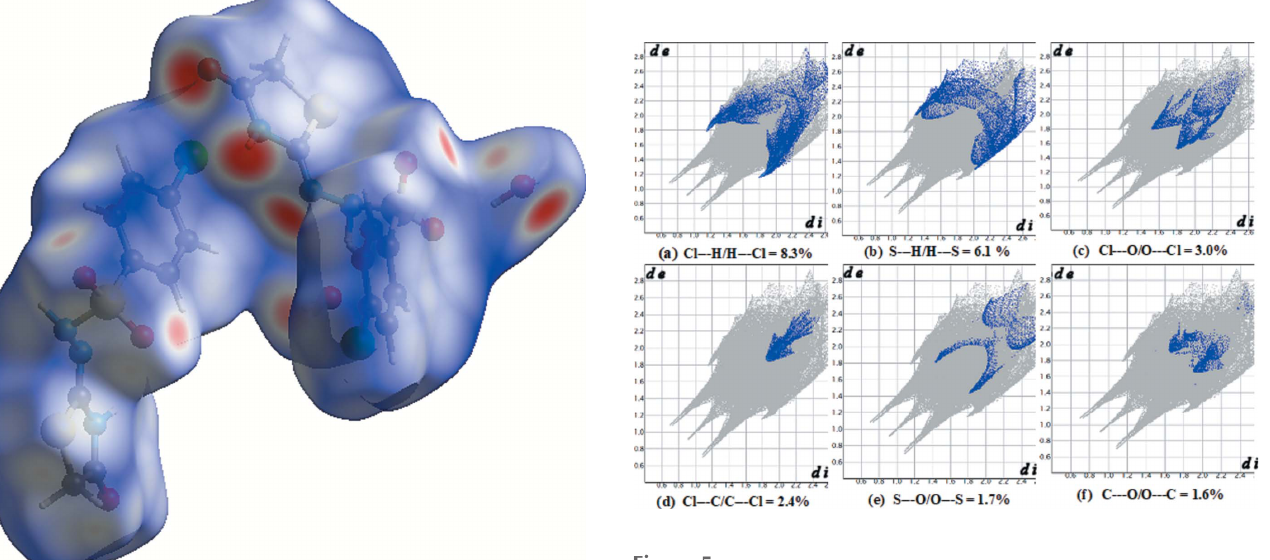
Figure 5 Fingerprint plots of interactions, listing their percentage contributions: ( a ) Cl (cid:2)(cid:2)(cid:2) H/H (cid:2)(cid:2)(cid:2) Cl, ( b ) S (cid:2)(cid:2)(cid:2) H/H (cid:2)(cid:2)(cid:2) S, ( c ) Cl (cid:2)(cid:2)(cid:2) O/O (cid:2)(cid:2)(cid:2) Cl, ( d ) Cl (cid:2)(cid:2)(cid:2) C/ C (cid:2)(cid:2)(cid:2) Cl, ( e ) S (cid:2)(cid:2)(cid:2) O/O (cid:2)(cid:2)(cid:2) S and ( f ) C (cid:2)(cid:2)(cid:2) O/O (cid:2)(cid:2)(cid:2)